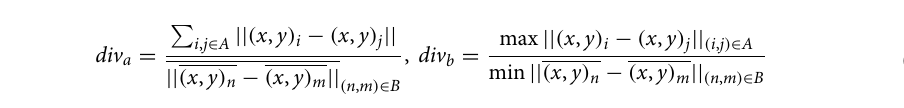
Figure 5. PCA analysis databases of AFM, SEM surfaces. ( a , b ) The coefficients of averaged local windows of AFM ( a ) and SEM ( b ). ( b ) images and the normalized mean deviation of true surface from fitted surface are reduced to two variables using PCA. The colors indicate annealing duration, and the shapes denote the scaled and unscaled mean deviation iterations of PCA. For the scaled iteration, mean deviation was scaled until it reached the largest significance among the PCA variables. ( c ) Colored boxes represent the maximum height of each annealing phase surface with their corresponding error bars indicating the maximum height’s standard deviation. Grey columns represent the normalized mean deviation for each annealing phase, which is used as the additional variable for